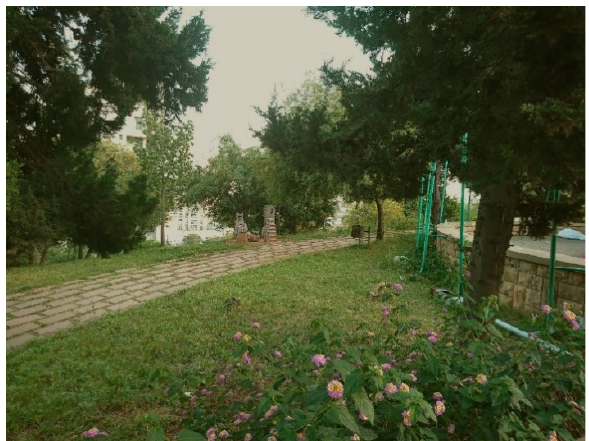
Figure 3. The Sioufi park in Achrafieh district, Beirut (adapted from Maria A. El Helou photo archive)